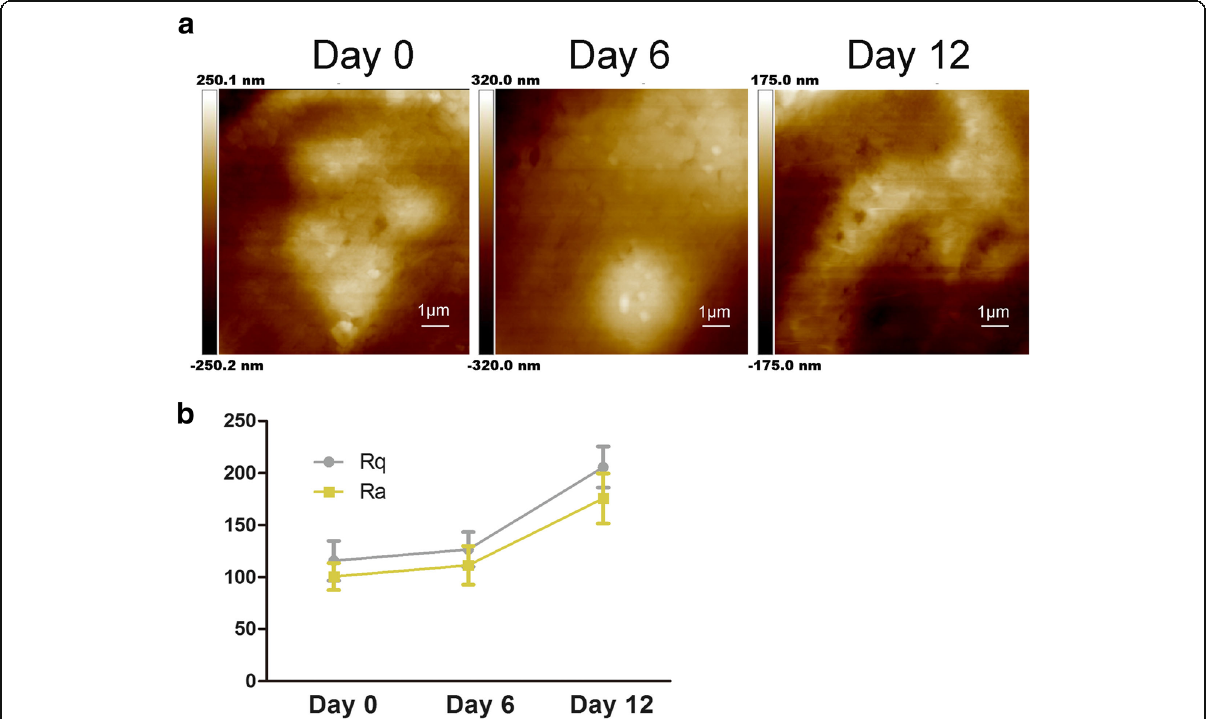
Fig. 2 Characteristics of hADSc membrane ultrastructure during chondrogenic differentiation. a Changes in cell membrane ultrastructure were assessed after chondrogenic differentiation for 0, 6, and 12 days. b The surface roughness parameters Ra and Rq of cells were measured during chondrogenic induction of hADSc for 0, 6, and 12 days